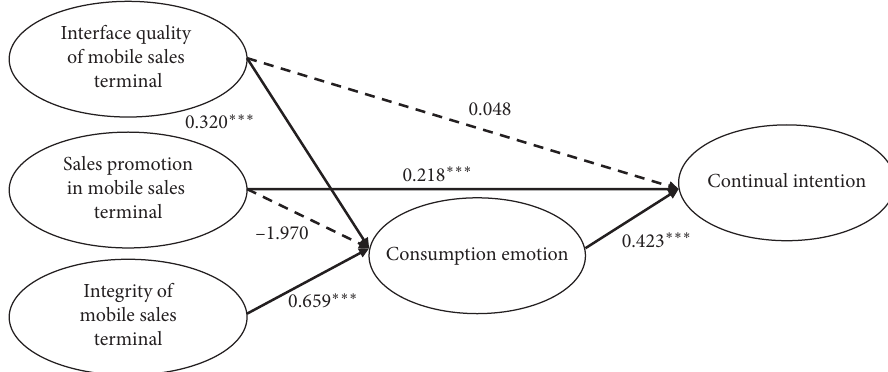
Figure 6: The relationships between variables. RMSEA � 0.033; GFI � 0.957; AGFI � 0.930; CMIN/DF � 1.412. Note . ∗∗∗ represents P < 0 . 001, and the path coefficients are standardized path coefficients.